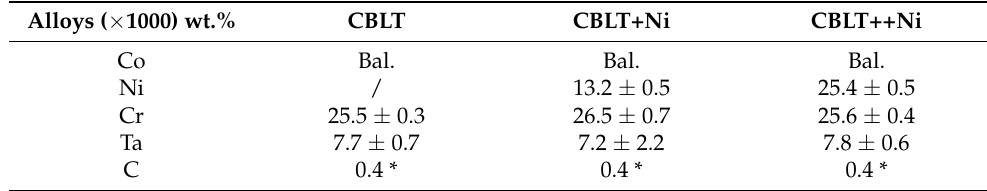
Table 1. Chemical compositions of the three obtained alloys (average and standard deviation calculated from five EDS × 1000 full frame measurements; * C not measurable by EDS but considered as well